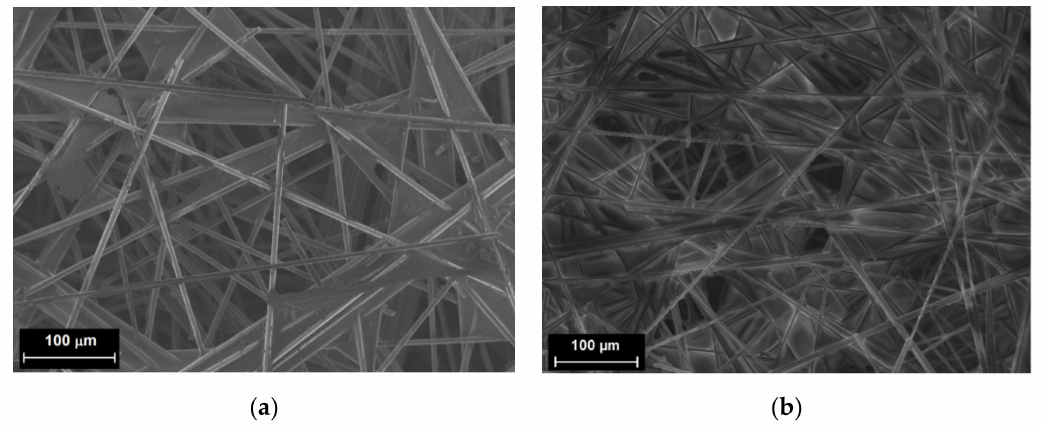
Figure 5. SEM-images of the FCVE ( a ) and the TrX100 / FCVE ( b )